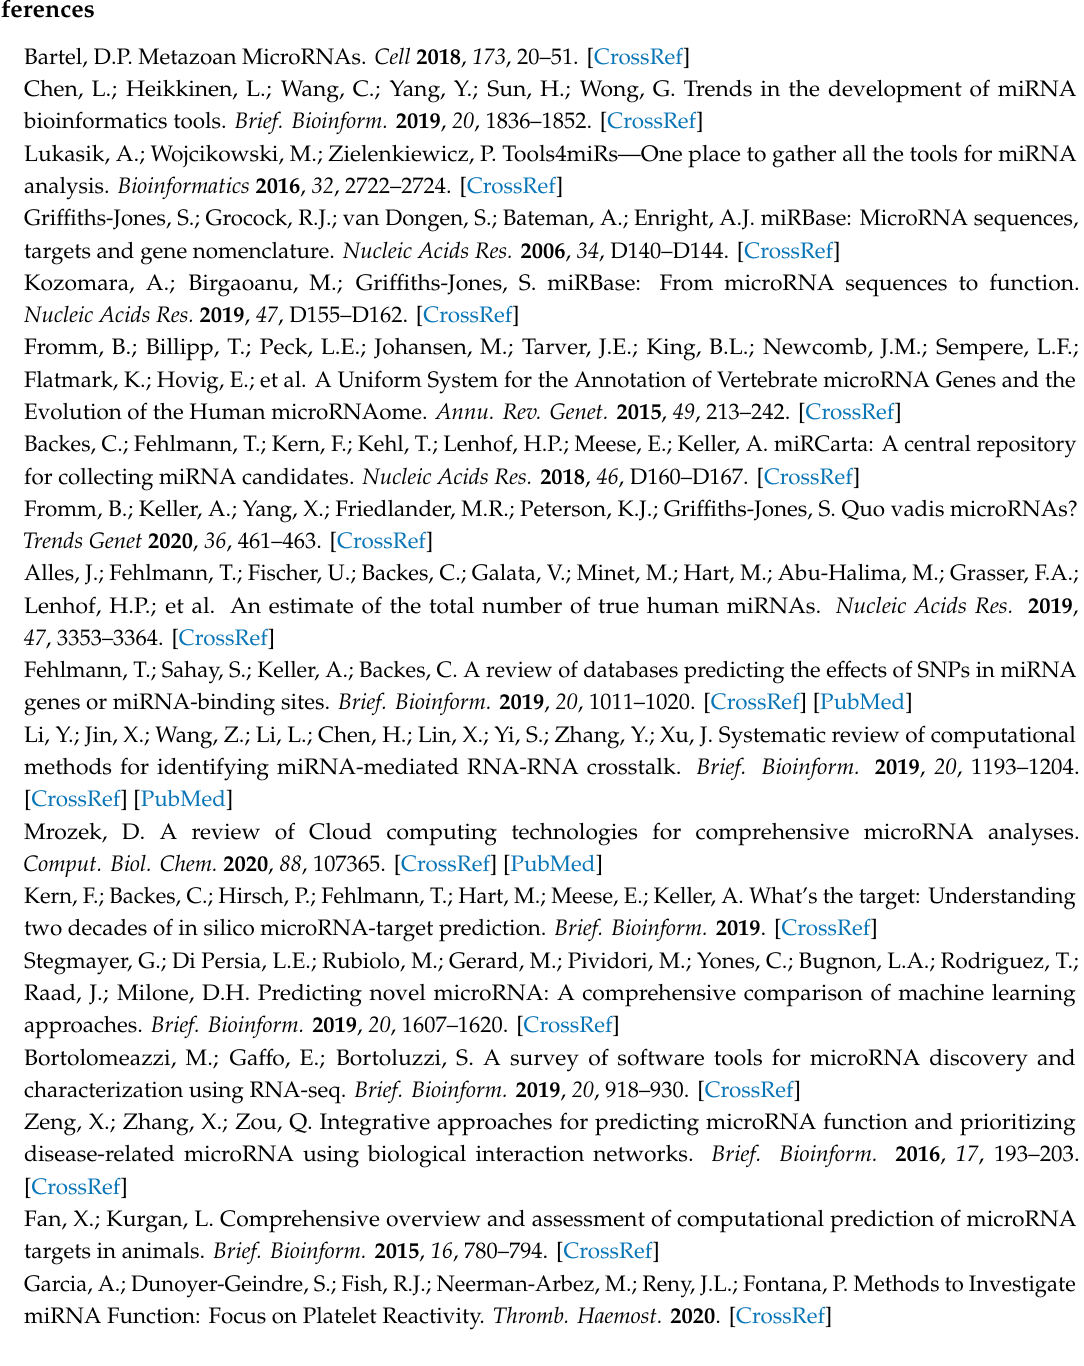
Table S1: A list of potential associations that can be used to build comprehensive